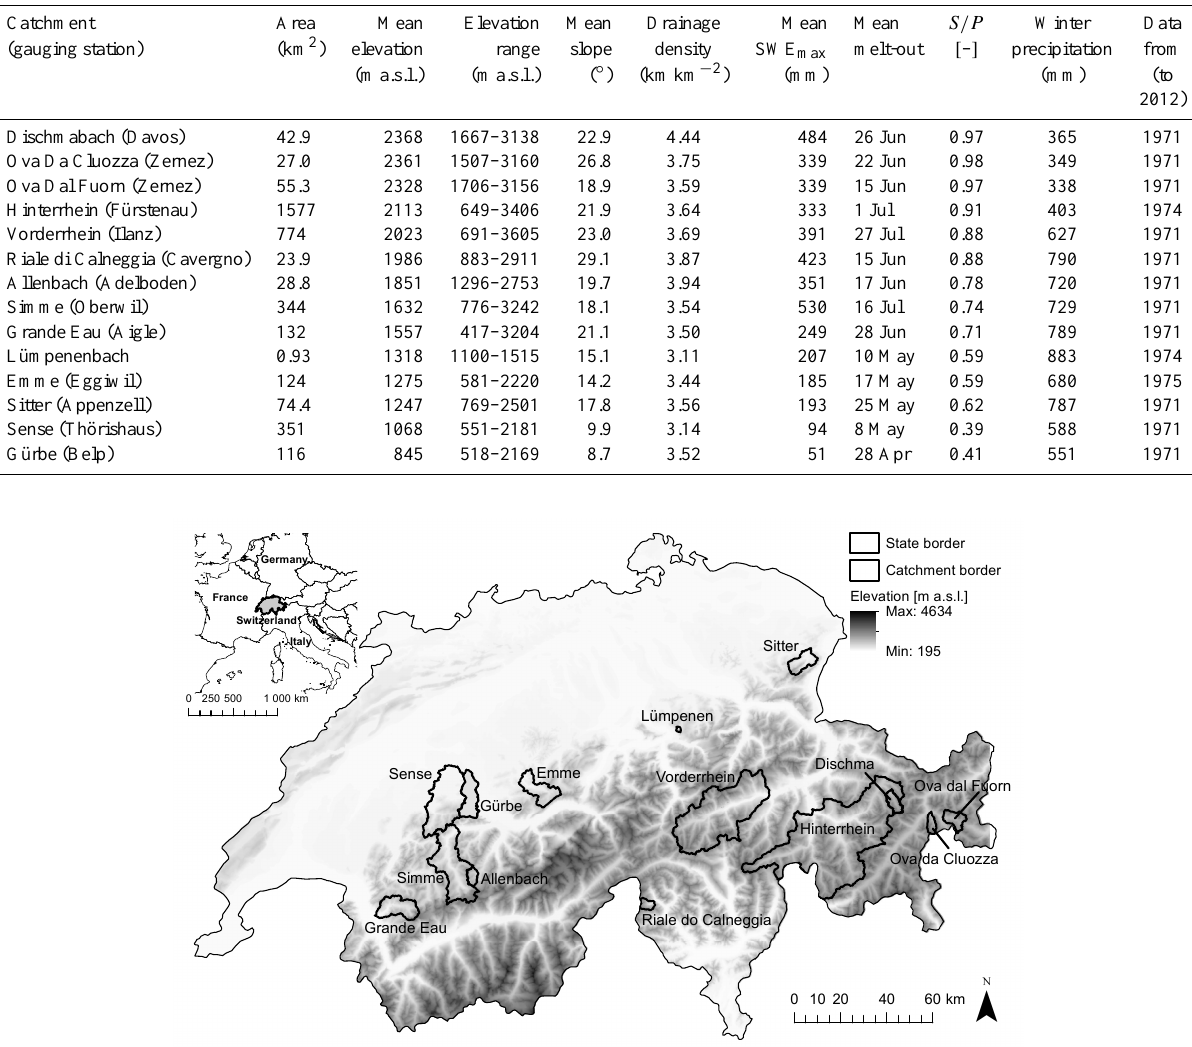
Figure 1. Location of the study catchments in Switzerland.